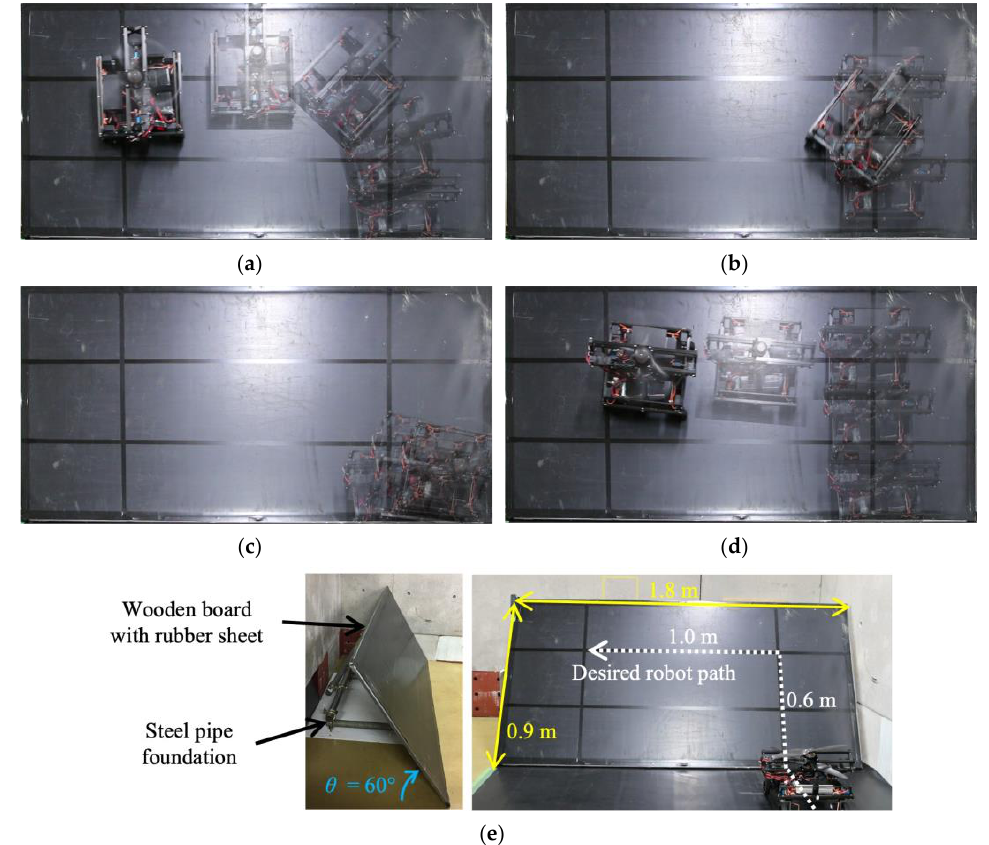
Figure 7. Experiment of moving on a rubber slope with four steering methods. ( a ) Two-wheel steering, ( b ) skid steering, ( c ) Mecanum wheels, ( d ) four-wheel steering, and ( e ) experimental setting. The two- and four-wheel steering methods were able to reach the destination